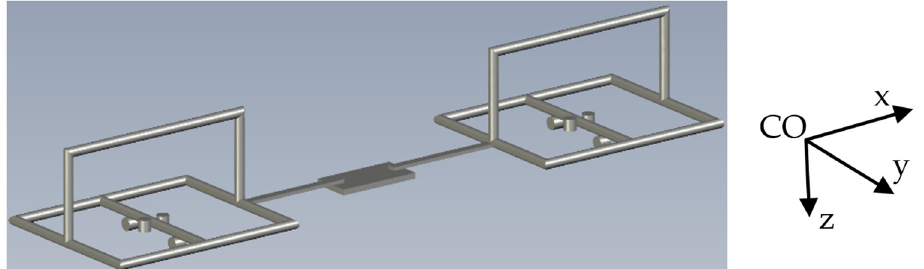
Figure 3. Three-dimensional CAD model of the transportation system (developed with Solid- Works [60]).